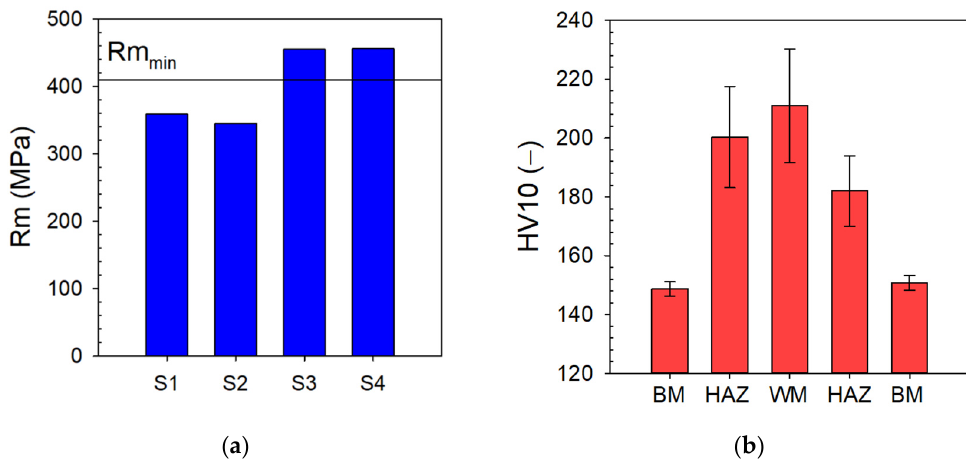
Figure 4. ( a ) Tensile test and ( b ) hardness test results.